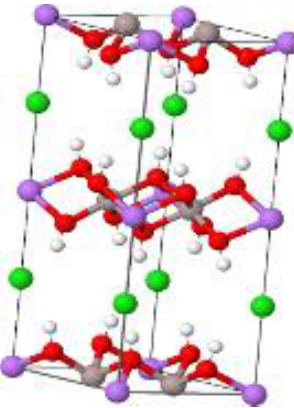
Figure 12. Crystal structure of lithium – aluminum double hydroxide (Li Al 2 (OH) 6 Cl) [126]. Li, Al, Cl, O, and H represented as purple, gray, green, red, and white, respectively. Reproduced with permission from Wiley. Wu, L.L. et al. (2019) Lithium – aluminum-layered double hydroxide chlorides (LDH): Formation enthalpies and energetics for lithium-ion capture. J Am Ceram Soc 2019, 102, 2398 – 2404.